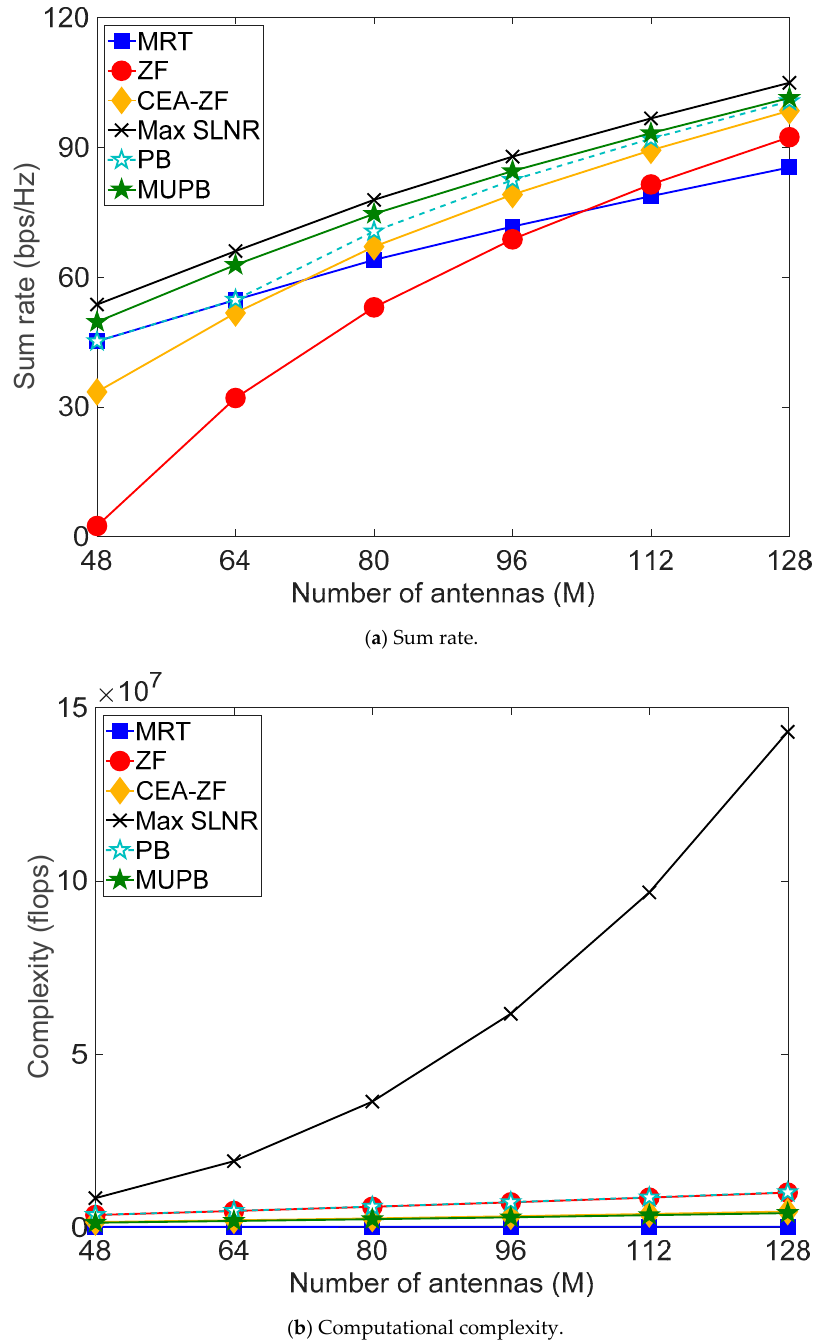
δ = − 6 6 dB . Figure 7. Performance according to M when K = 16 and th th